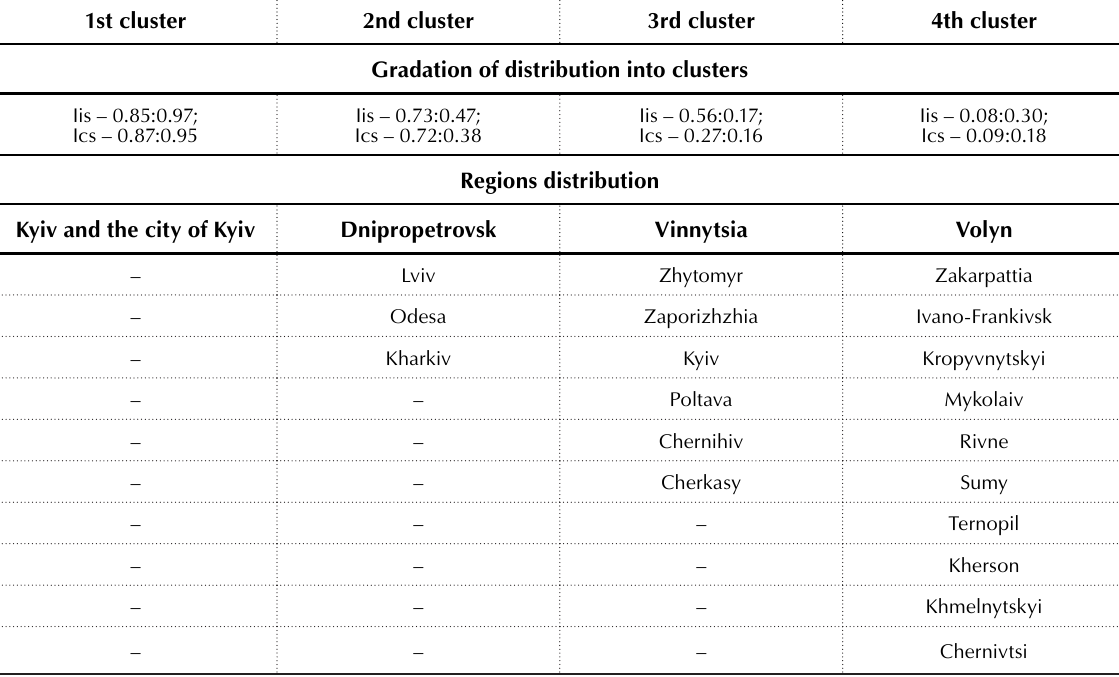
Table 2. Structure of the aggregate of the Ukrainian regions according to the clusters formed depending on the values of the ICI components 1st cluster 2nd cluster 3rd cluster 4th cluster Gradation of distribution into